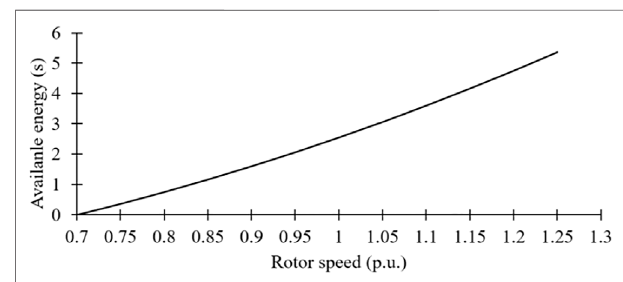
FIGURE 2 | Available kinetic energy of a